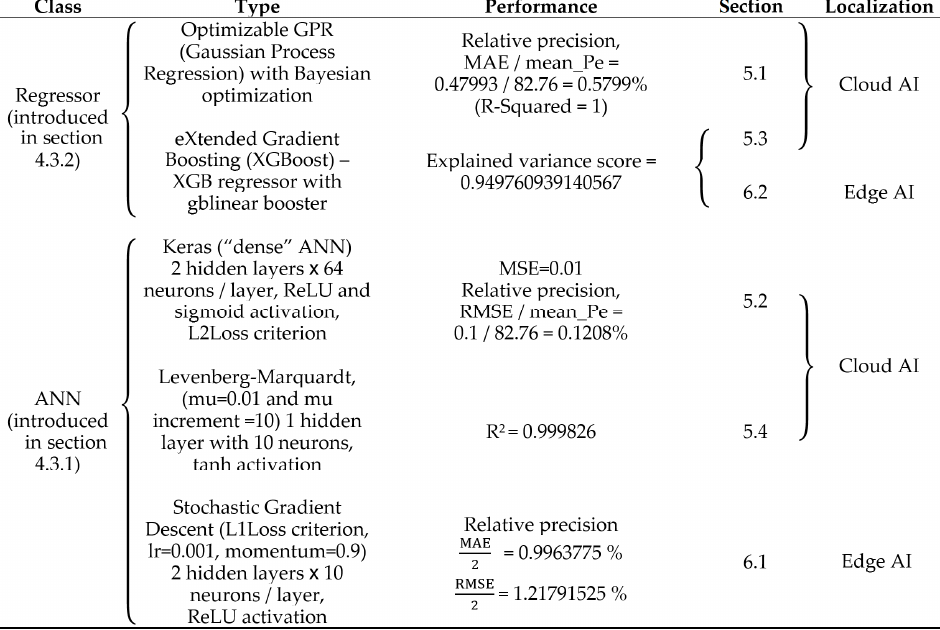
Figure 21. Comparison of the AI solutions for smart devices (referred with their section numbers).